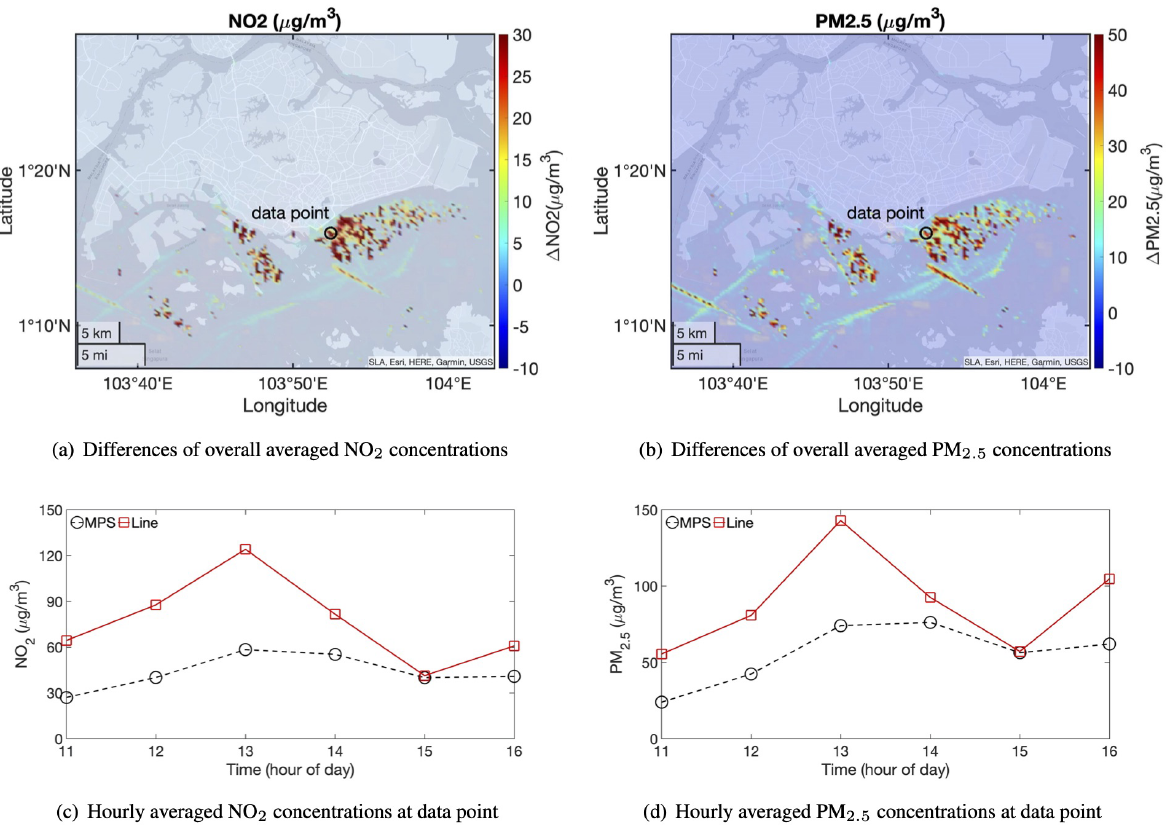
Figure 18. Emission concentrations during the entire simulation period predicted by the MPS and LS models. Note that in panels (a) and (b) , the 2D plots show the differences of the overall averaged concentrations during the entire simulation period (6h) predicted by using the LS and MPS models (differences = LS results − MPS results). In panels (c) and (d) , the curves present the hourly averaged concentrations predicted by two models at the location of the data point shown in panels (a) and (b) , where large differences